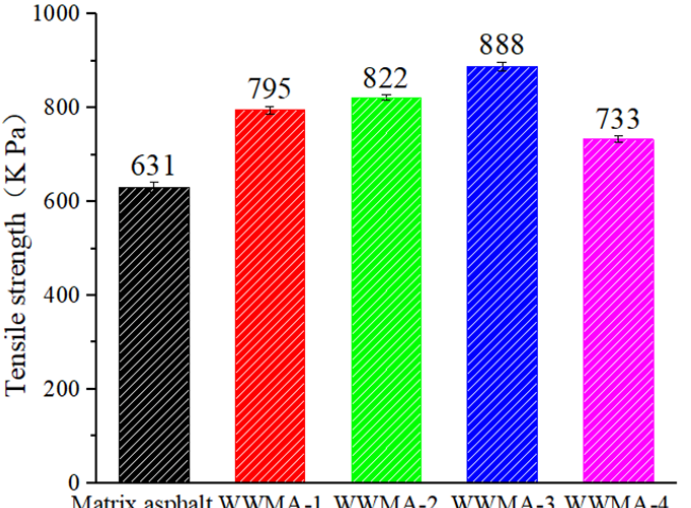
Figure 13. Tensile strength of asphalt and limestone cube.